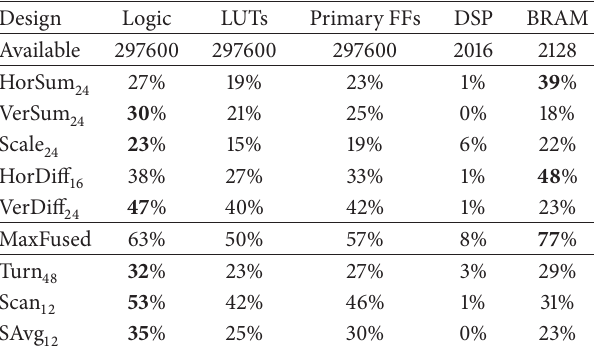
Table 3: Resource utilization of the implemented kernels, critical resource